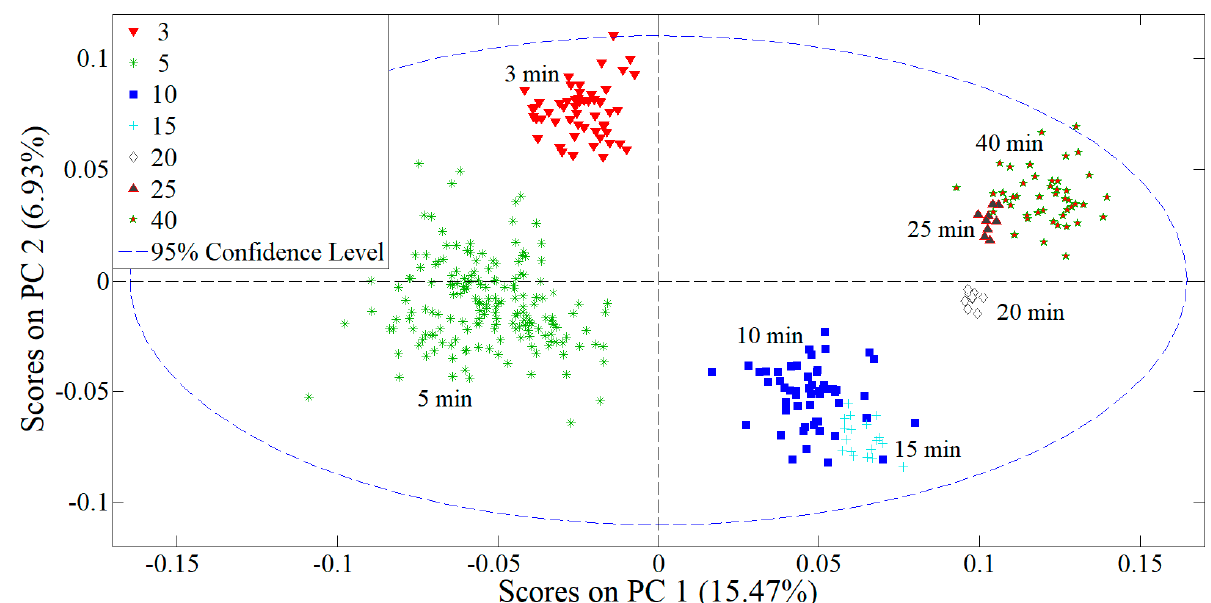
Figure 3. PC1 versus PC2 score plot in the decomposition model obtained using the first four PCs and data array containing wavenumbers in the 1800–650 cm − 1 range (entire spectral region captured by FTIR). The plot indicates clustering of the spectra with respect to time spent in a vacuum chamber.